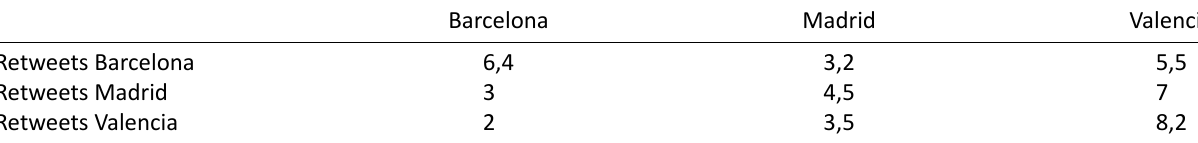
Table 3. Retweets registered based on the geographical location of users (in millions).